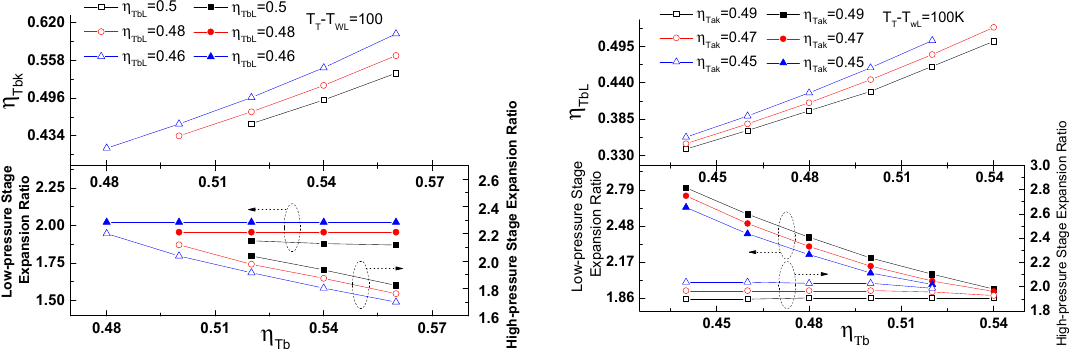
Figure 7. Relationship between the total turbocharger efficiency, the efficiency of the turbocharger at each stage, and the expansion ratio of each stage.